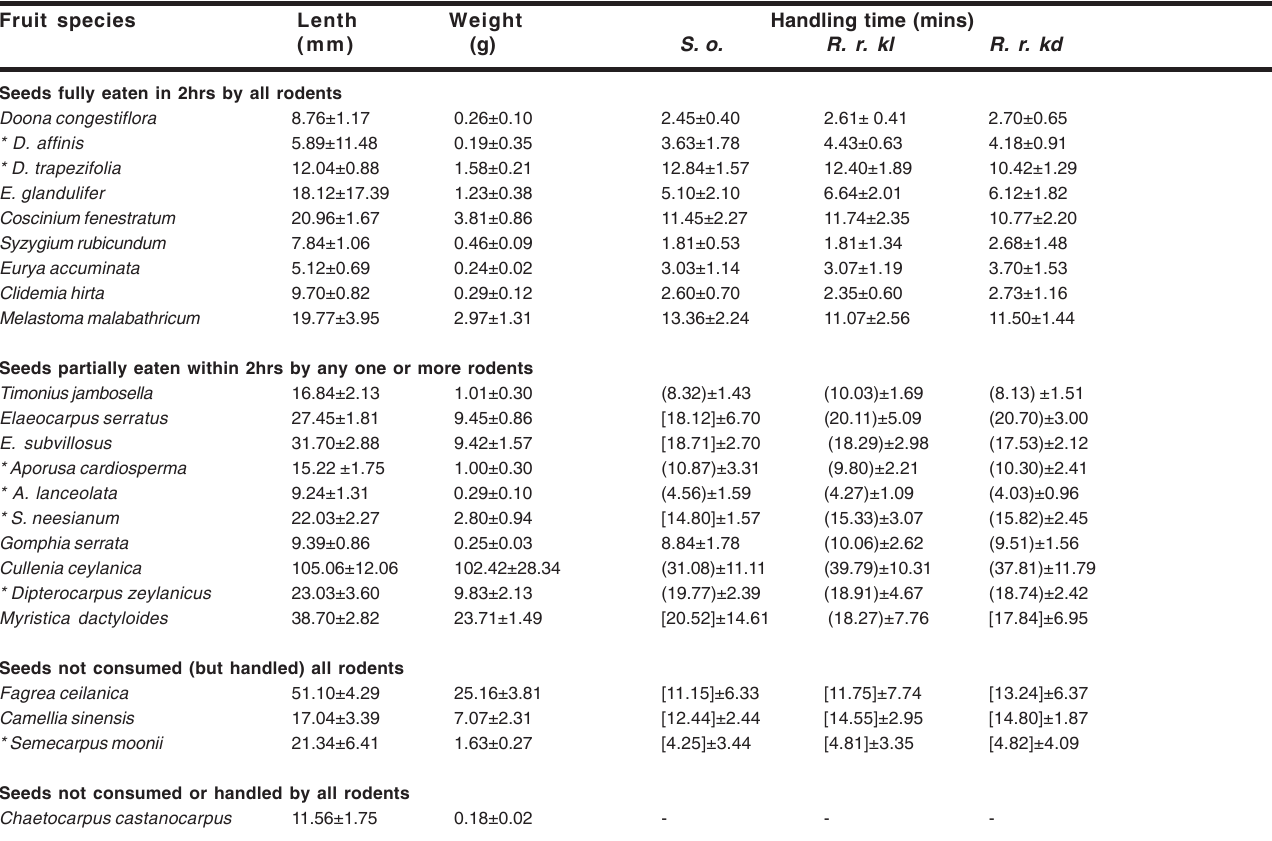
Table 2. The mean lengths and weights (n=50) and the mean handling times (± standard deviations) of 25 fruit types collected from areas within and adjacent to the Sinharaja forest. Handling time is the average time (n=5) an animal spent handling and consuming (totally or partially) one fruit within the first two hours of supplying it. The handling times were recorded for the three taxa Srilankamys ohiensis ( S. o. ), Rattus rattus kelaarti ( R. r. kl. ) and R. r. kandianus ( R. r. kd. ) separately. Table show handling times of fruit types that were fully consumed, not fully consumed within two hours (round parentheses), not consumed but nevertheless handled (square parentheses) and neither consumed nor handled (-) are also shown. No standard deviations have been given in instances where only one individual was seen to handle a food